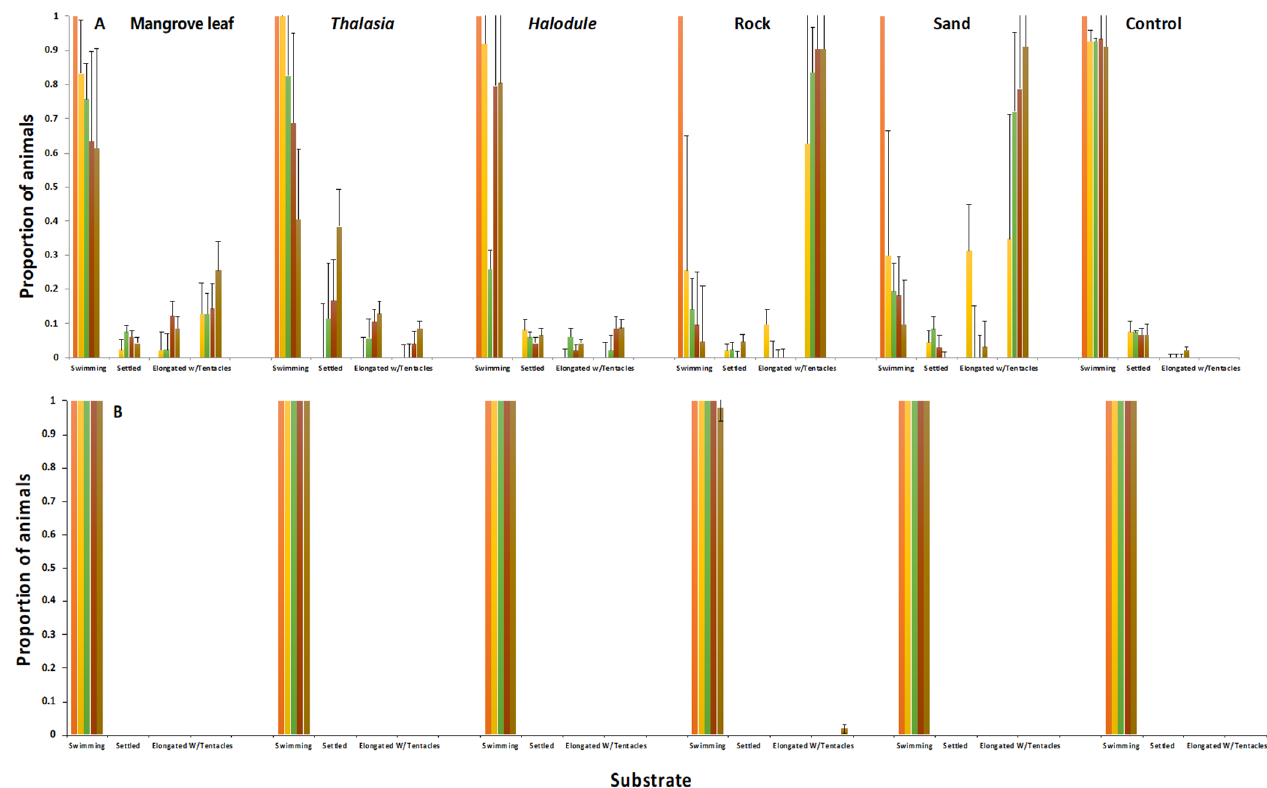
Figure 5. Settlement and metamorphosis into polyps of C. xamachana ( A ) and C. frondosa ( B ) in response to the inducer Z-